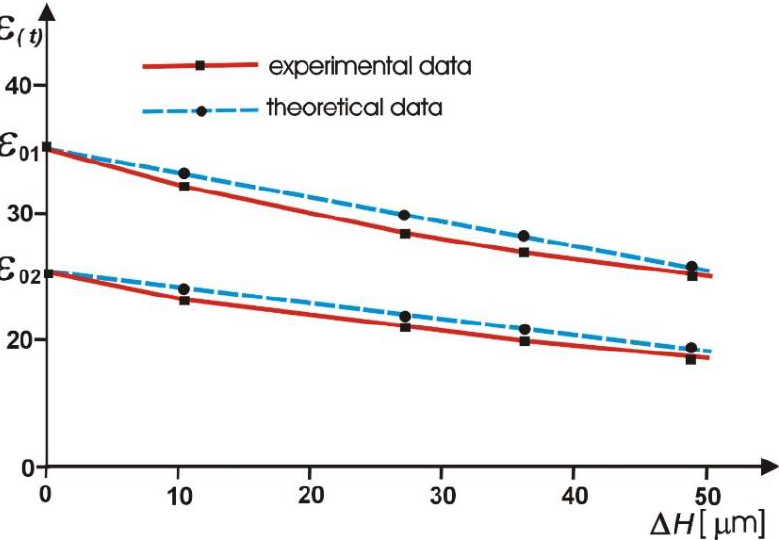
Figure 11. The comparison of experimental and theoretical values of the reduction of the run—out deviation ( ε O ) of a grinding wheel in the ECDGW-AC process.